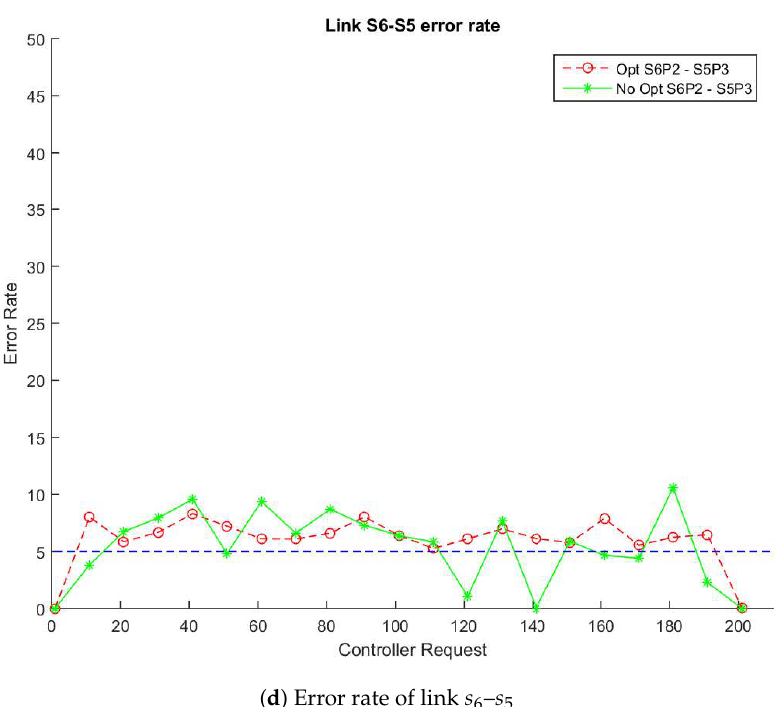
Figure 3. Enhanced vs. Non-Enhanced Data and Error Rate of Highway_cif.